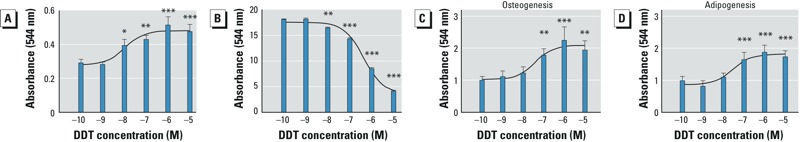
Proliferation, self-renewal, and differentiation of MSCs cultured with 10–10 M, 10–9 M, 10–8 M, 10–7 M, 10–6 M, or 10–5 M DDT for 5 days. (A) Proliferation determined using the MTT assay; treated cells were plated (500 cells/well) in a 96-well plate and analyzed 7 days later. (B) Self-renewal of treated cells that were plated at low density for 14 days, and fixed and stained with crystal violet; only colonies > 2 mm2 in diameter were counted. (C,D) Quantification of osteogenic (C) or adipogenic (D) differentiation. All samples were normalized to the amount of protein present. For details of experiments, see “Materials and Methods.” Values (mean ± SD) represent triplicates and three independent experiments for each of the three donors (n = 27).
*p < 0.05, **p < 0.01, and ***p < 0.001, compared with vehicle treatment alone.